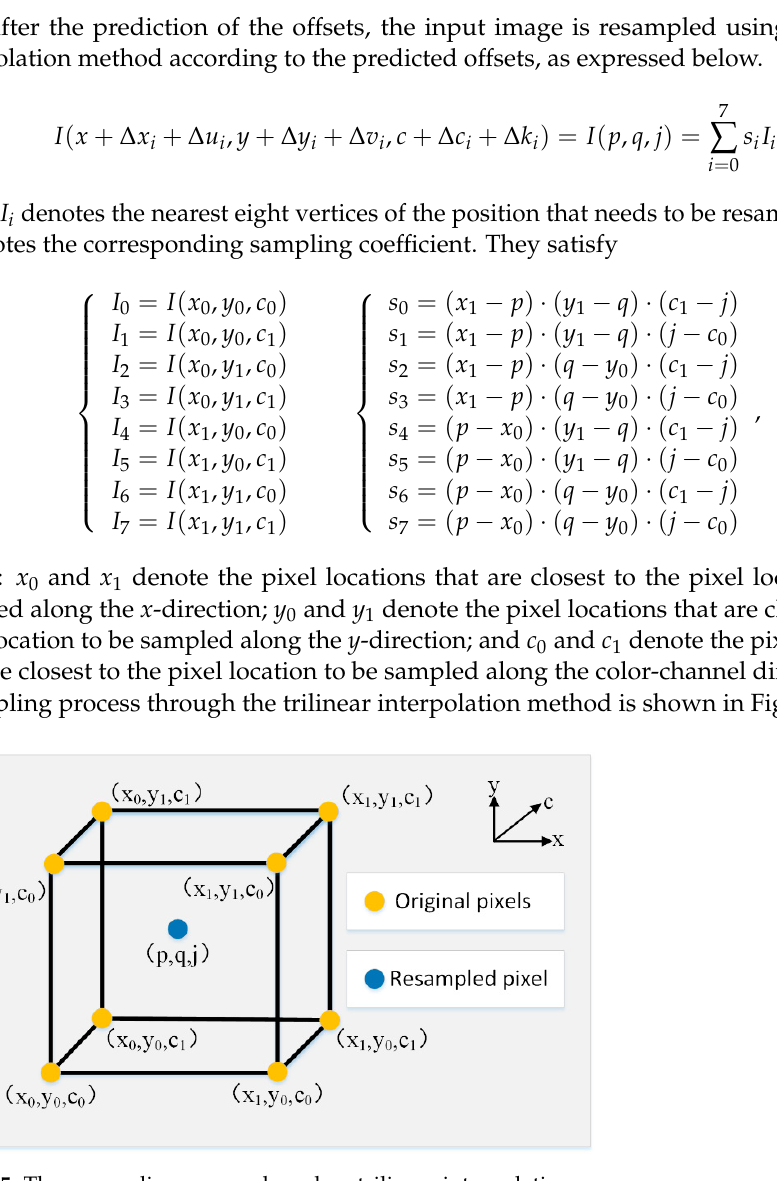
Figure 5. The resampling process based on trilinear interpolation. The offset-prediction subnet predicts offsets relative to a three-dimensional cubic fil-